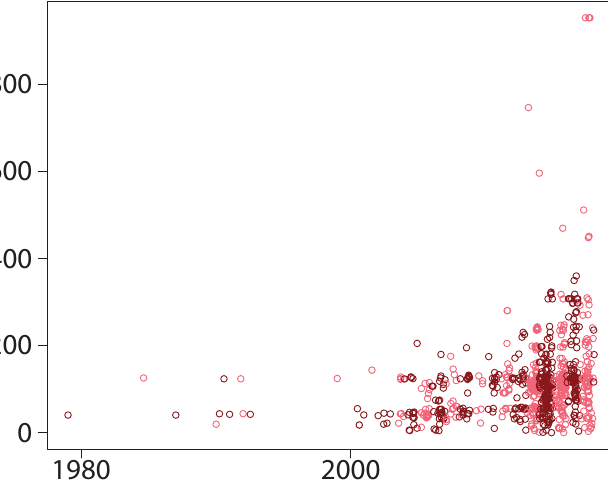
(Fig. 5A) together with an egg sac behind a street sign next to a paved boardwalk (17. IX.2018, 48.8331N, -1.5879W, T. Bauer leg.). Webs of the species could also be found between sea defence rocks directly at the coastline (48.8342N, -1.5929W) as well as on trees in a small urban forest fragment (48.8334N, -1.5892W) next to the location of the female. Around 100 spiderlings emerged from the egg sac in